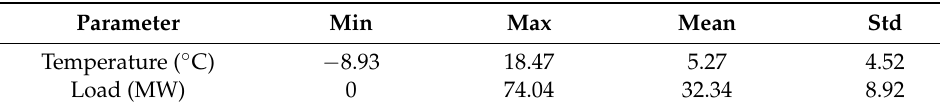
Figure 4. Heat consumption and outdoor temperature. Table 1. Statistical characteristics of raw